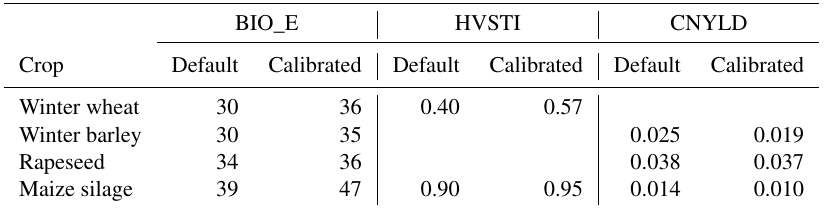
Table 3. Default and calibrated plant parameters. BIO_E Plant radiation use efficiency for corn (MJm − 2 ), HVSTI Harvest index (–), CNYLD Nitrogen content in yield (kgN per